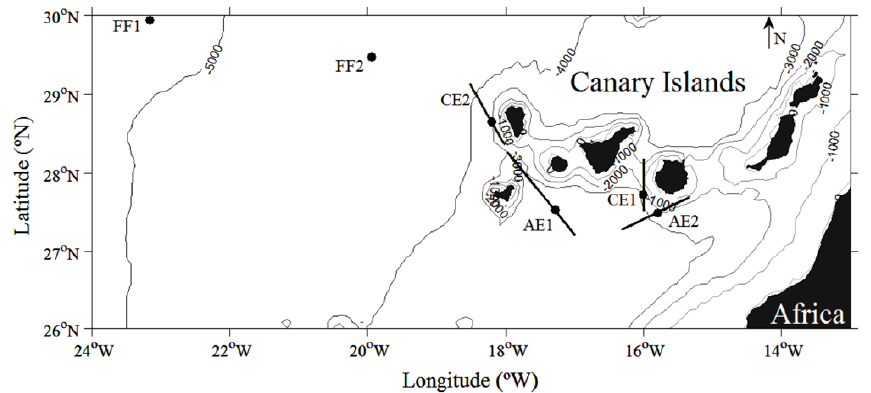
Fig. 1. Observational domain. Black dots indicate the location of the biogeochemical stations at the far-field (FF1, FF2) and at the center of the cyclonic eddies (CE1, CE2) and anticyclonic eddies (AE1, AE2). Black lines indicates the location of the XBT transects crossing the eddies.